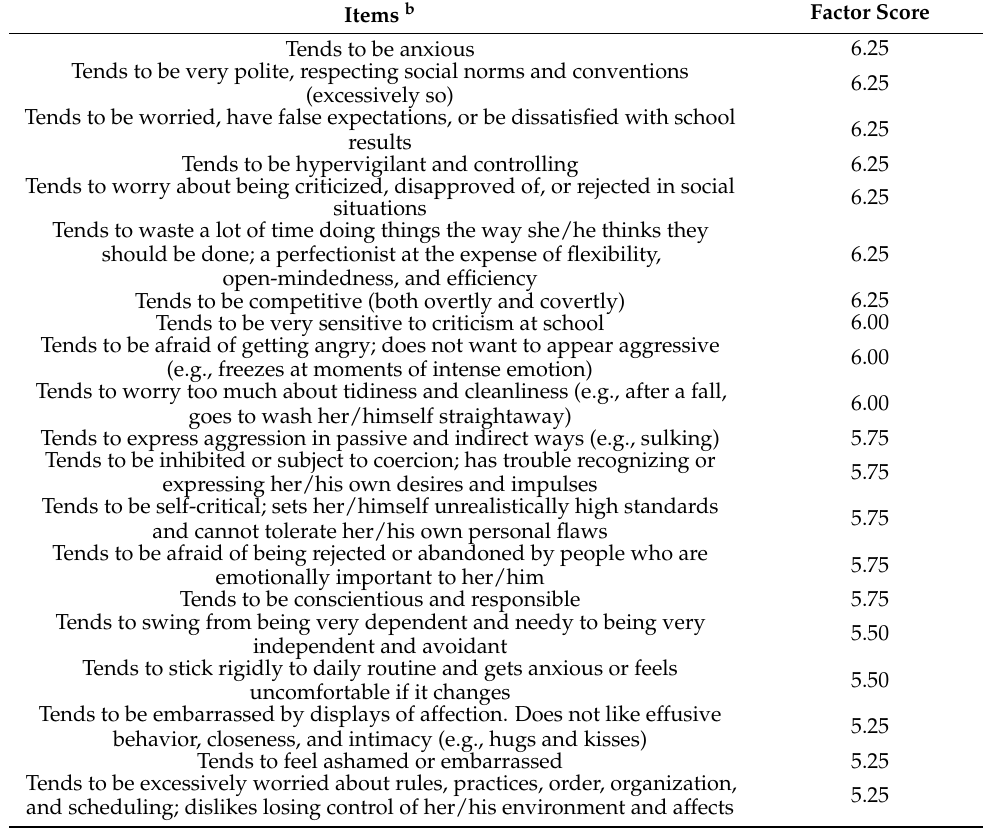
Table 6. Best CPAP-Q a items of the obsessive